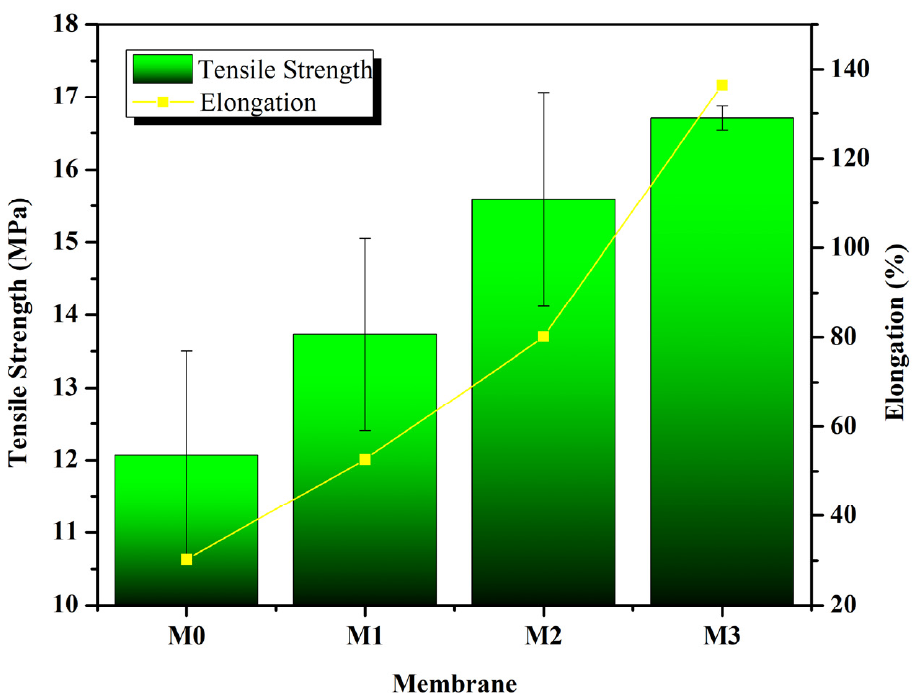
Figure 2. Mechanical properties of the fabricated membrane at several polymer compositions. The data was found based on mechanical tests using the Autograph AGS J standard as ASTM D 638-14 with a tensile speed of 10 mm/min.